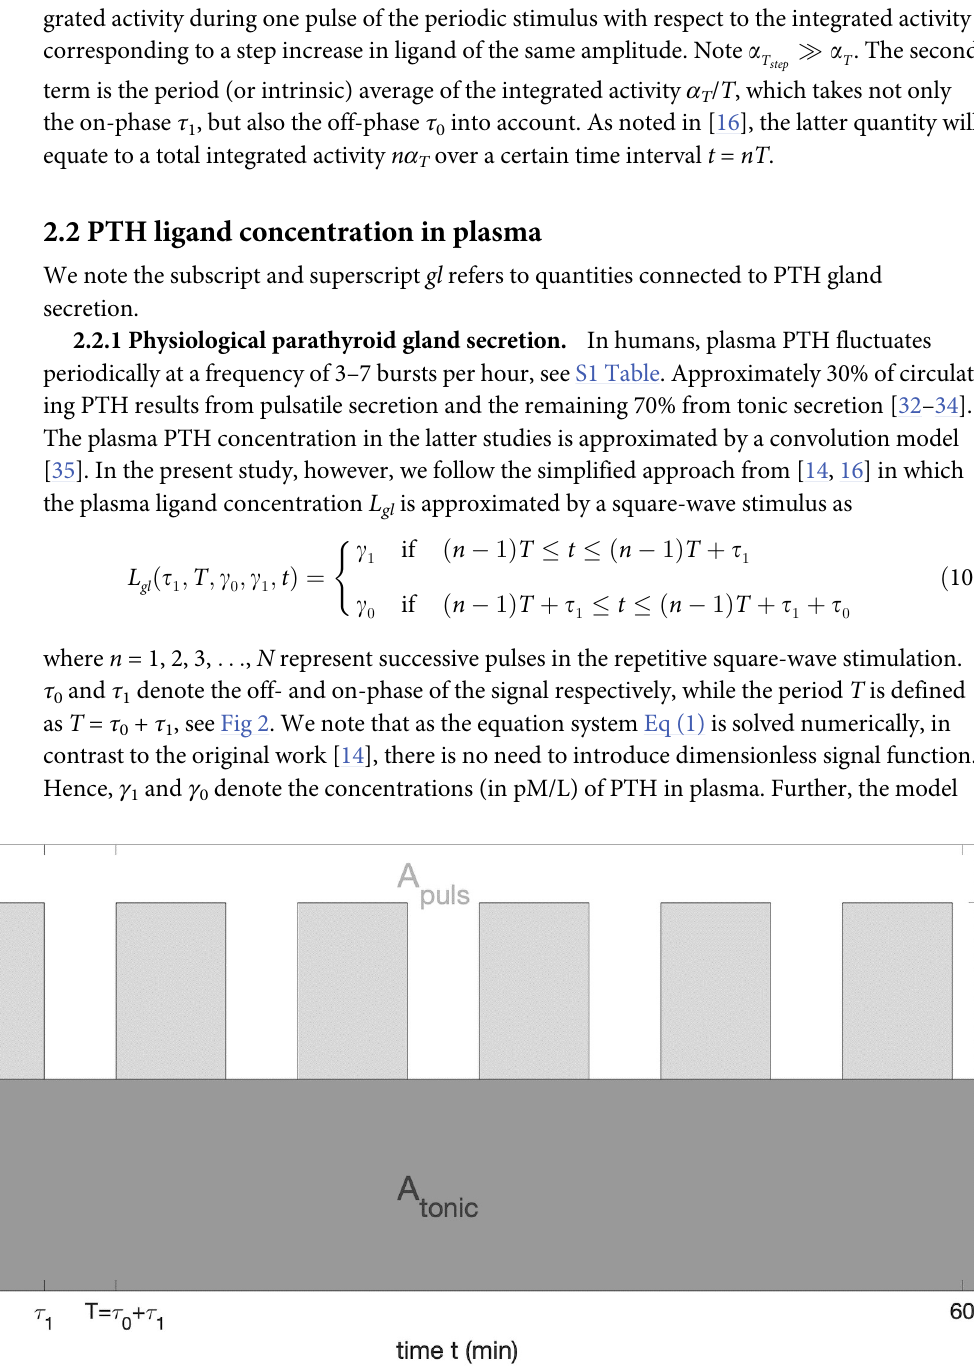
Fig 2. Schematic representation of the square-wave PTH ligand concentration L (in plasma) vs. time. γ 1 is the peak PTH concentration gl due to pulsatile glandular secretion, γ 0 is the PTH concentration due to tonic glandular secrection, and τ 0 and τ 1 are the off- and on-phases of pulsatile component. Dark grey area A represents the plasma concentration resulting from a tonic secretion whereas the light grey area tonic A puls represents the plasma concentration resulting from the pulsatile